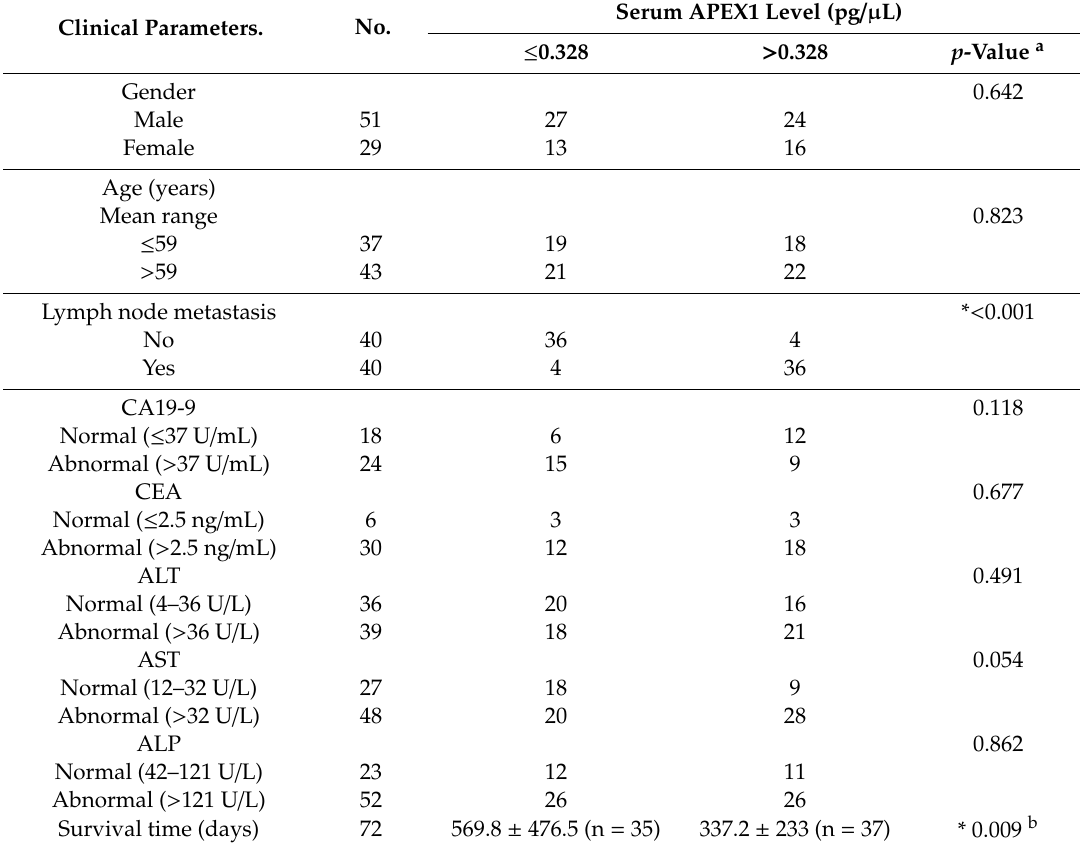
Table 4. Correlation between serum APEX1 level and clinicopathological features of CCA patients. Clinical Parameters.